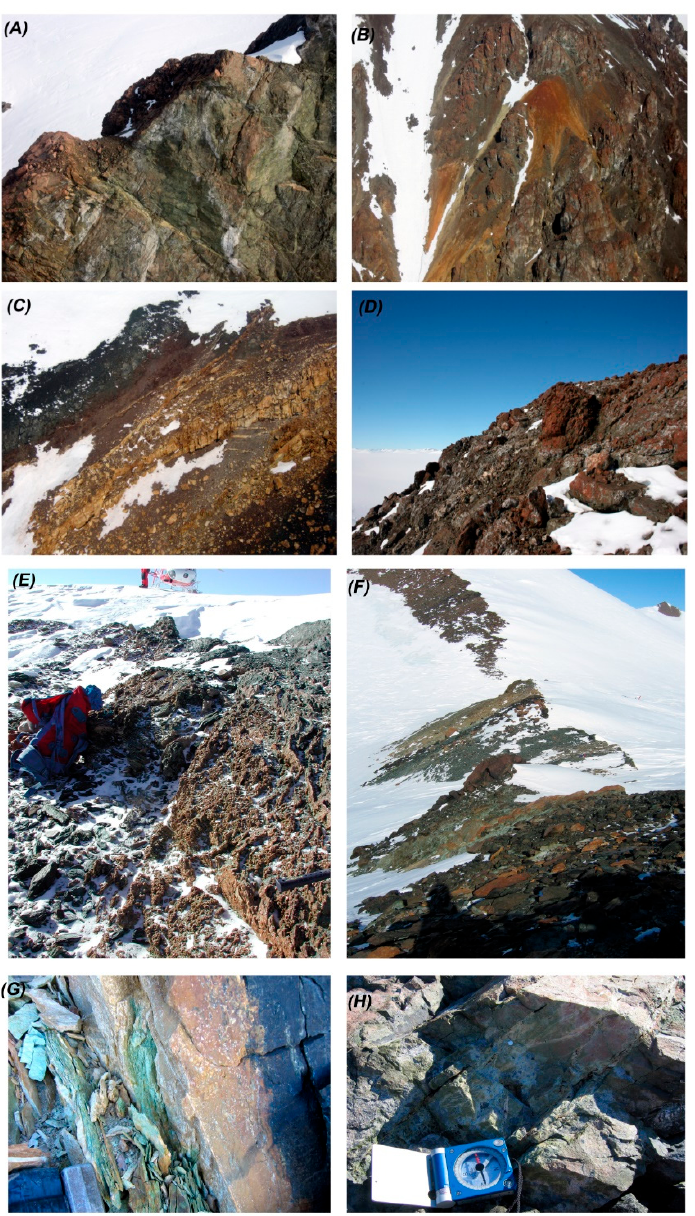
Figure 12. Field photographs of the typical altered rocks and listvenites. ( A ) Helicopter view of the fault zone characterized by epidote–prehnite–quartz coatings, and epidotization in Glasgow Volcanics country rocks, Mt Gow, Bowers Mountains; ( B ) Helicopter view of the reddish (iron oxide/hydroxide minerals) to greenish (chlorite-epidote minerals) alterations of Glasgow Volcanics along fault zones, NE slopes of Mt Gow, Bowers Mountains; ( C ) Helicopter view of the metasomatic alteration (carbonate dominated) of Glasgow Volcanics around a quartz–carbonate fault vein system (Dorn Glacier, for details see [1]; ( D ) Close view of reddish alteration (iron oxide/hydroxide minerals dominated) along fault zones in Glasgow Volcanics, NE slopes of Mt Gow, Bowers Mountains; ( E ) Close view of shear zone with magnesite-talc-quartz mylonite derived from mafic and ultramafic rocks at the WT-BT boundary, Lanterman Range; ( F ) View of layers of alternating foliated ultramafite and amphibolite within mylonitic shear zone characterised by listvenite and magnesite-talc-quartz rich mylonite, WT-BT boundary, Lanterman Range; ( G ) Close view of listvenites from a shear zone at the WT-BT boundary, Lanterman Range. The foliated green rock is rich in Cr-muscovite and chlorite, the light brown part is rich in Fe-Mg carbonates; ( H ) Close view of a damage zone with intense epidotization (greenish to pinkish color) and silicification of the host Glasgow Volcanics Mt Gow, Bowers Mountains.